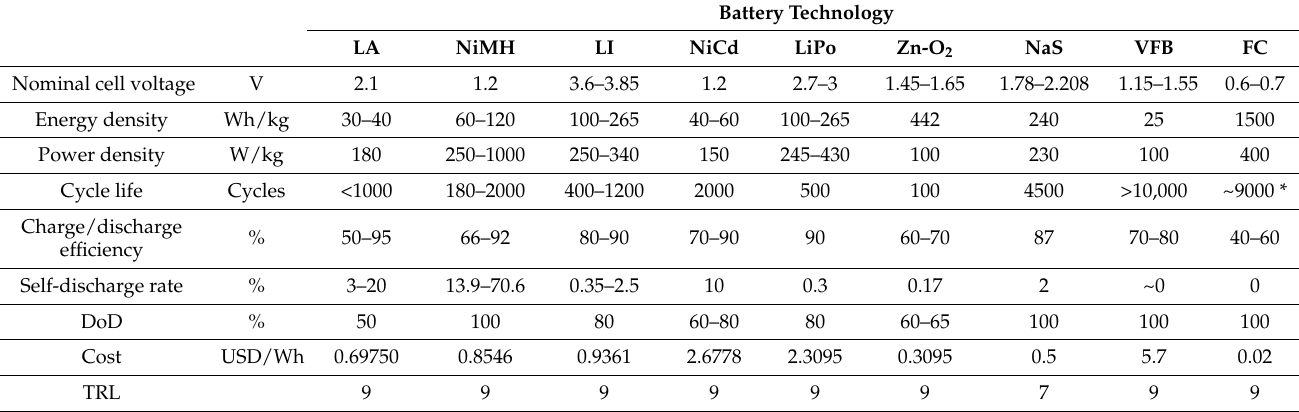
Table 1. Comparison of battery technology properties, adapted from